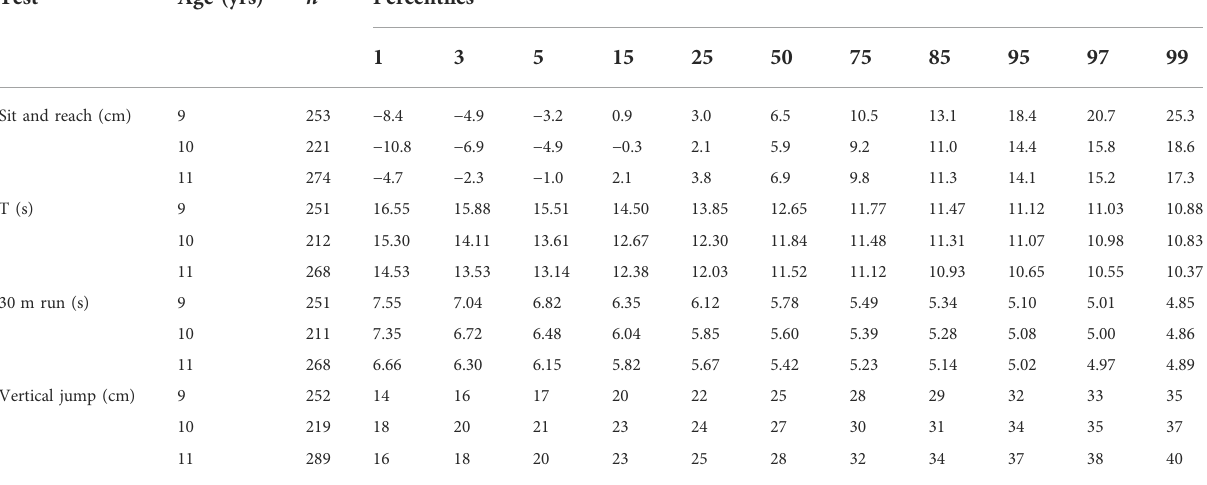
TABLE 3 Physical fi tness standard for campus football players aged 9 to